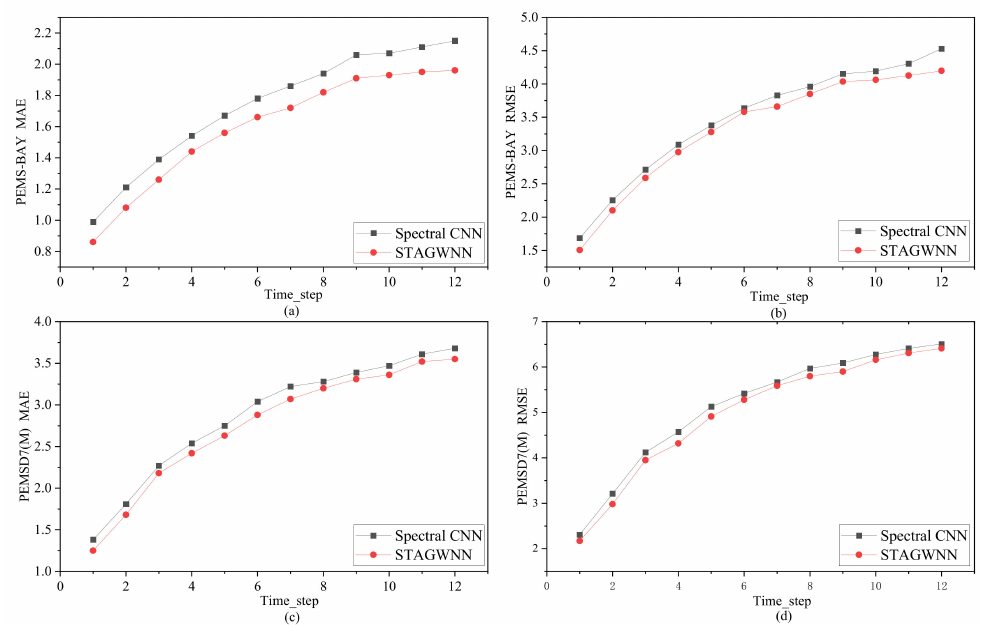
Figure 4. Performance comparison between STWGNN and Spectral CNN for the next 60 min predic- tion task. ( a , b ) are the variation curves of MAE and RMSE on the PEMS-BSY dataset, respectively; ( c , d ) are the variation curves of MAE and RMSE on the PEMSD7(M) dataset,